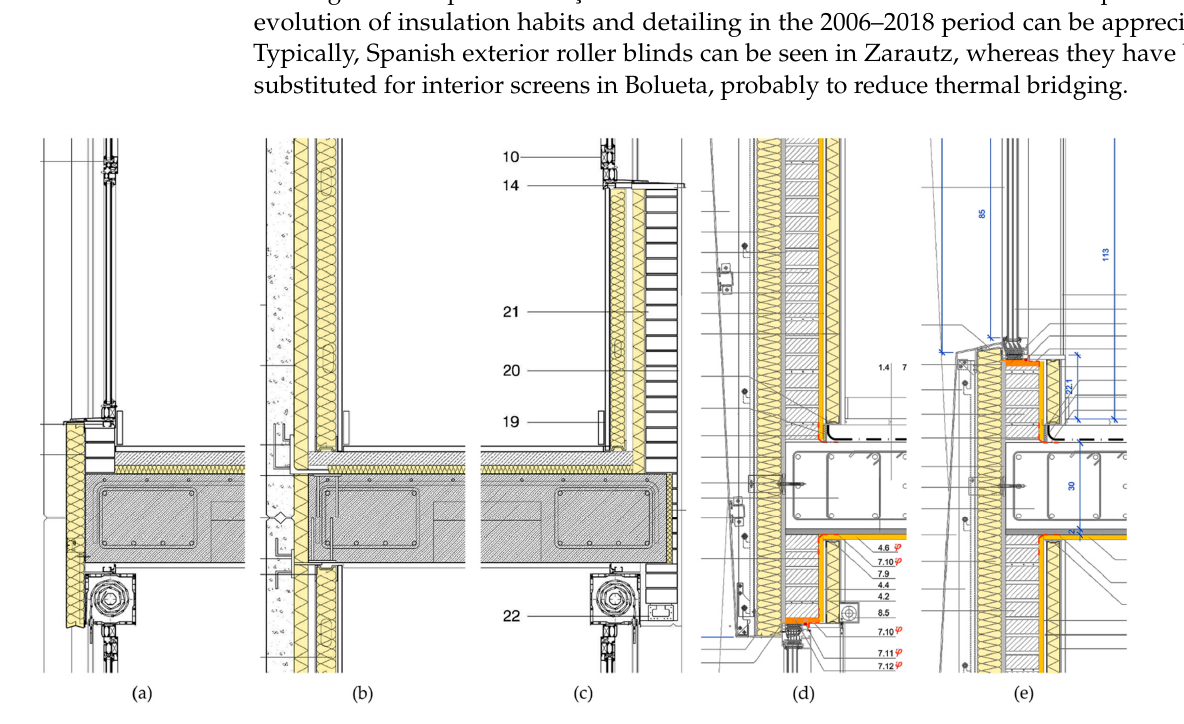
Figure 6. Vertical section detail comparison between the Zarautz and Bolueta case studies. ( a ) shows the slab-facing detail in the fenestration bands of the main façade in Zarautz, whereas ( b ) corresponds to the opaque section of the same façade and ( c ) shows the courtyard façade solution. Adapted by the authors from the Executive Project by SATIE Arquitectos. ( d ) and ( e ) show the equivalent details in Bolueta Tower 1. Adapted by the authors from the Executive Project by VArquitectos. An overview of the most relevant constructive element properties of the develop- ments are compiled in Table 3.